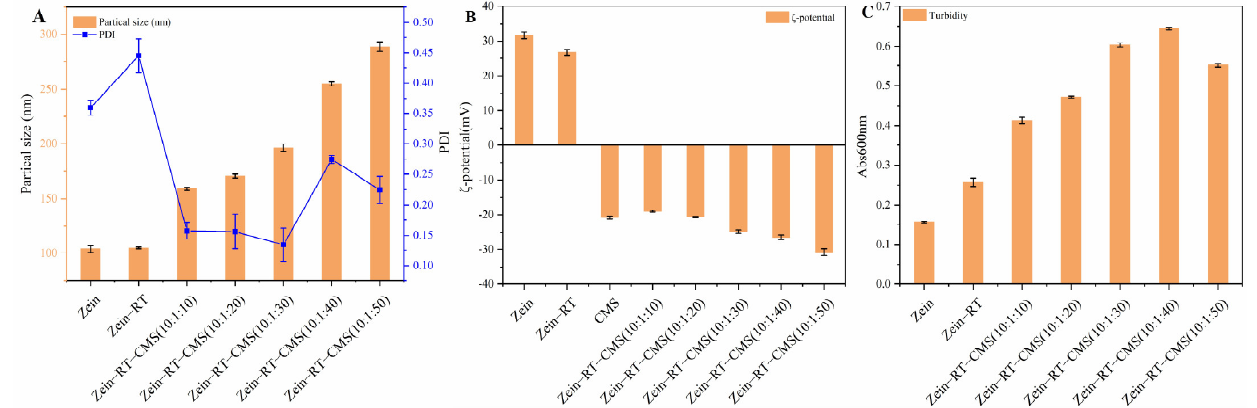
Figure 1. ( A ) Particle size and PDI of zein, zein–RT and zein–RT–CMS nanoparticles (at different levels of CMS); ( B ) ζ–potential of zein, zein–RT and zein–RT–CMS nanoparticles (at different levels of CMS); ( C ) turbidity of zein and zein–RT–CMS nanoparticles (at different levels of CMS). Electrostatic interaction plays an important role in protein–polysaccharide